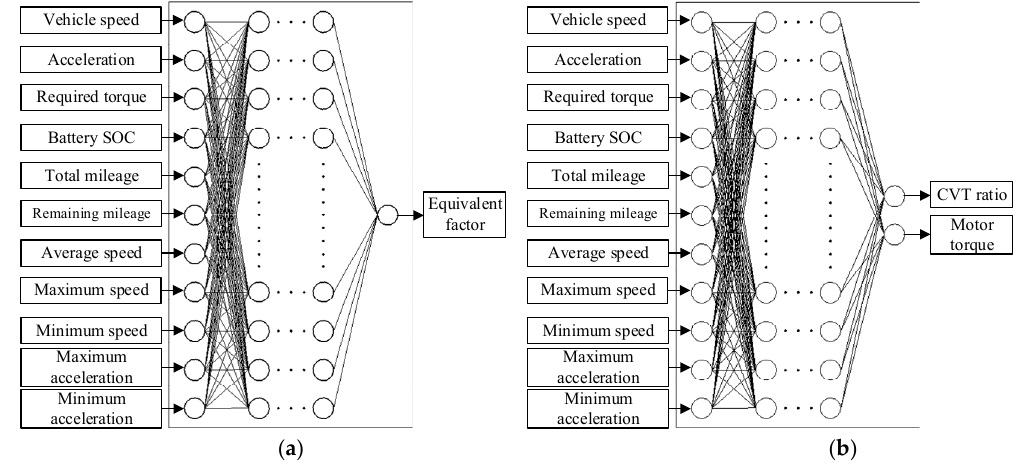
Figure 7. Neural network structure diagram, ( a ) Based on DP-A-ECMS; ( b ) Based on DP.